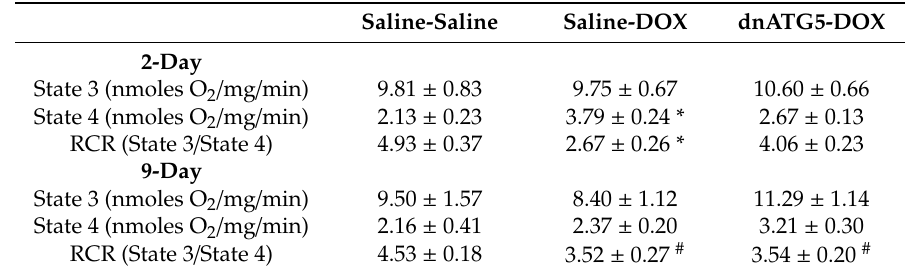
Table 3. Cardiac muscle mitochondria state 3 respiration, state 4 respiration and respiratory control ratio (RCR).